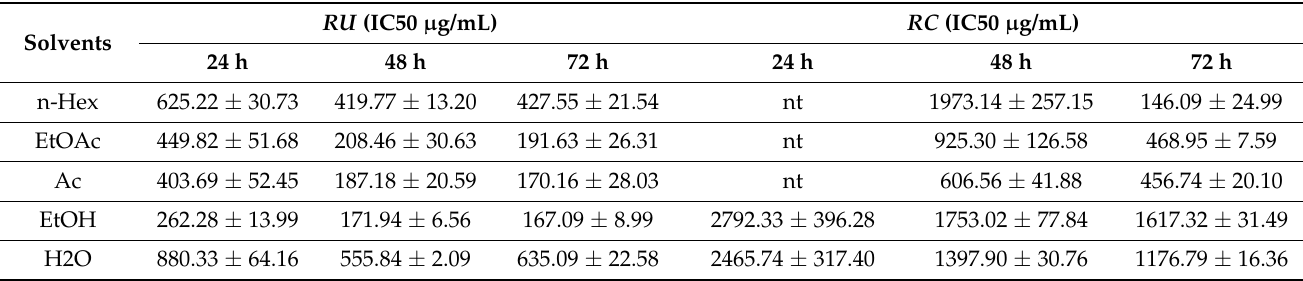
Table 4. IC50 values after 24, 48, and 72 h of treatment incubation of RU and RC